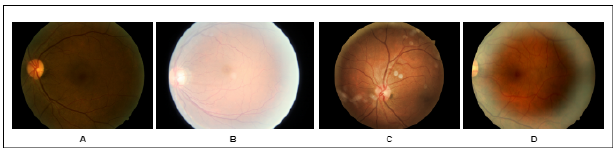
Figure 2. The example of publicly available data-set (Kaggle Data). (A) under exposure fundus image; (B) over exposure fundus image; (C) unrelated artifacts and (D) blurriness